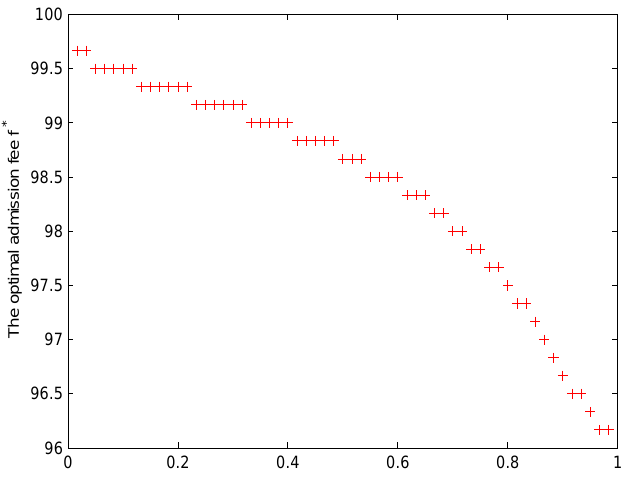
Figure 4. The optimal admission fee f ∗ with the growing ρ .